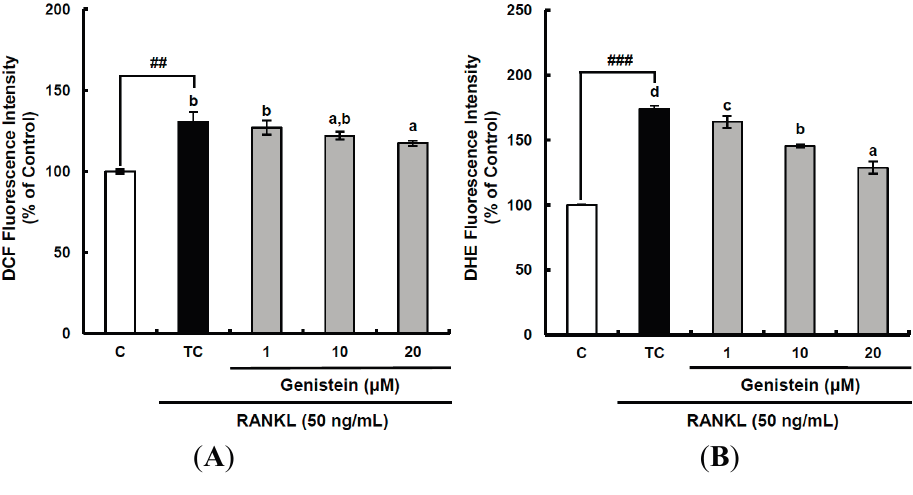
Figure 3. The suppressive effects of genistein on general ROS ( A ), superoxide anions ( B ) and GSH levels ( C ) during the receptor activator of nuclear factor kappa-B ligand (RANKL)-induced osteoclast differentiation. RAW 264.7 cells were seeded in